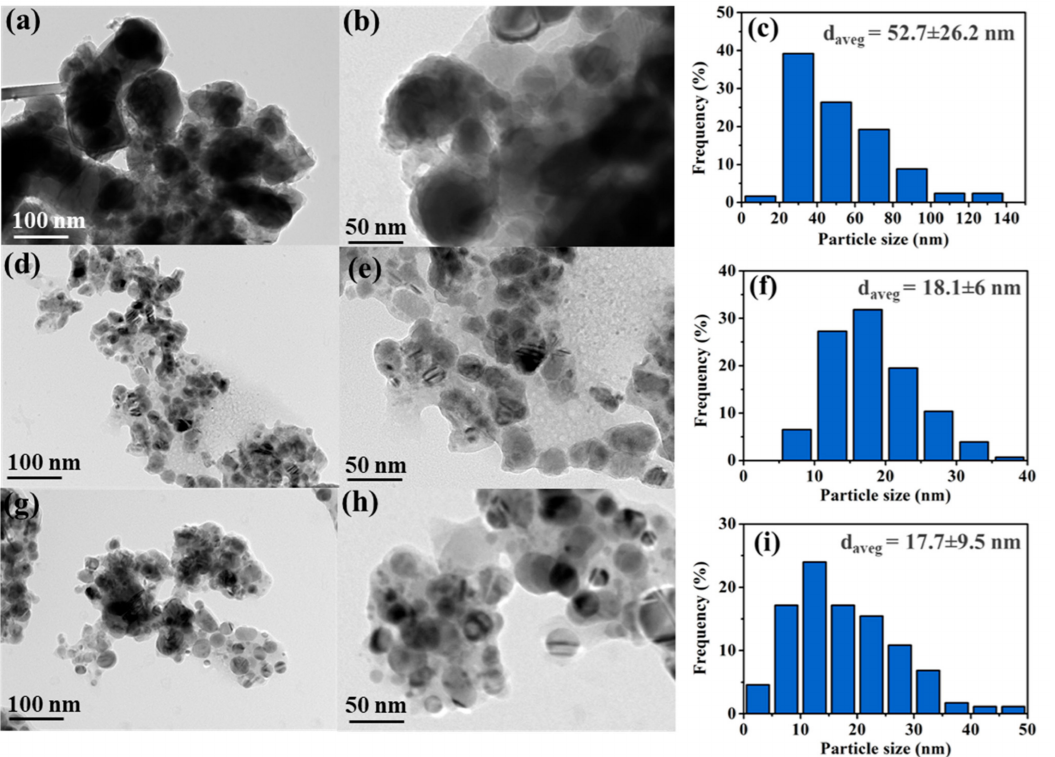
Figure 5. Typical TEM images and particle size distribution of reduced ( a – c ) Cu/CaO, ( d – f ) Co/CaO,